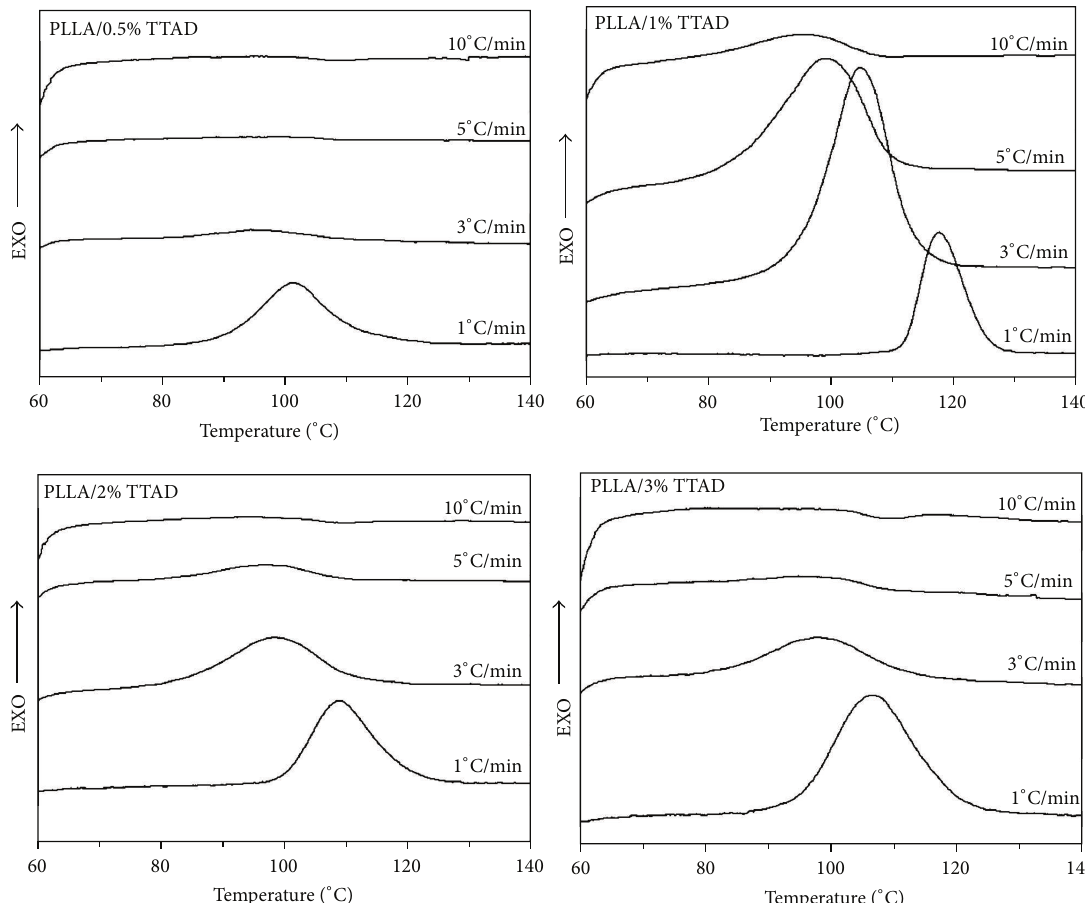
Figure 5: DSC curves of PLLA/TTAD with varying amounts of TTAD in the crystallization process at various cooling rates.